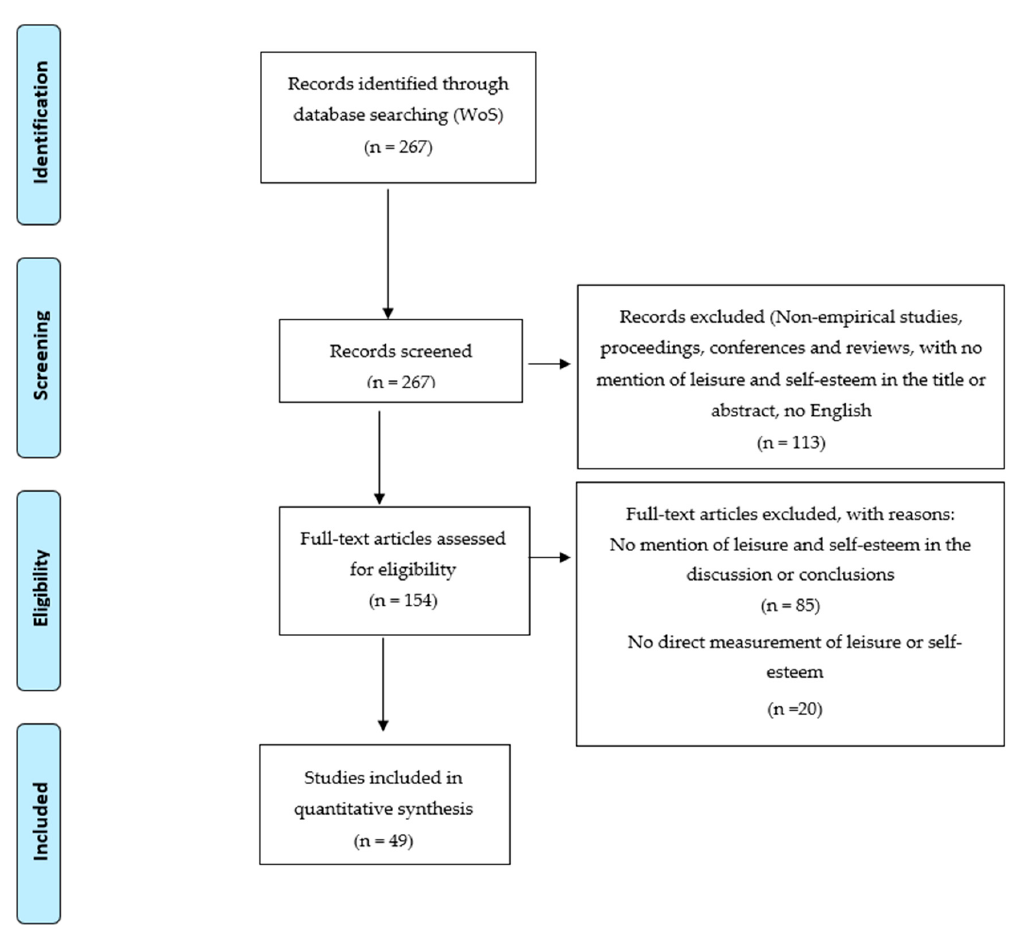
Figure 2. Selection of eligible articles.